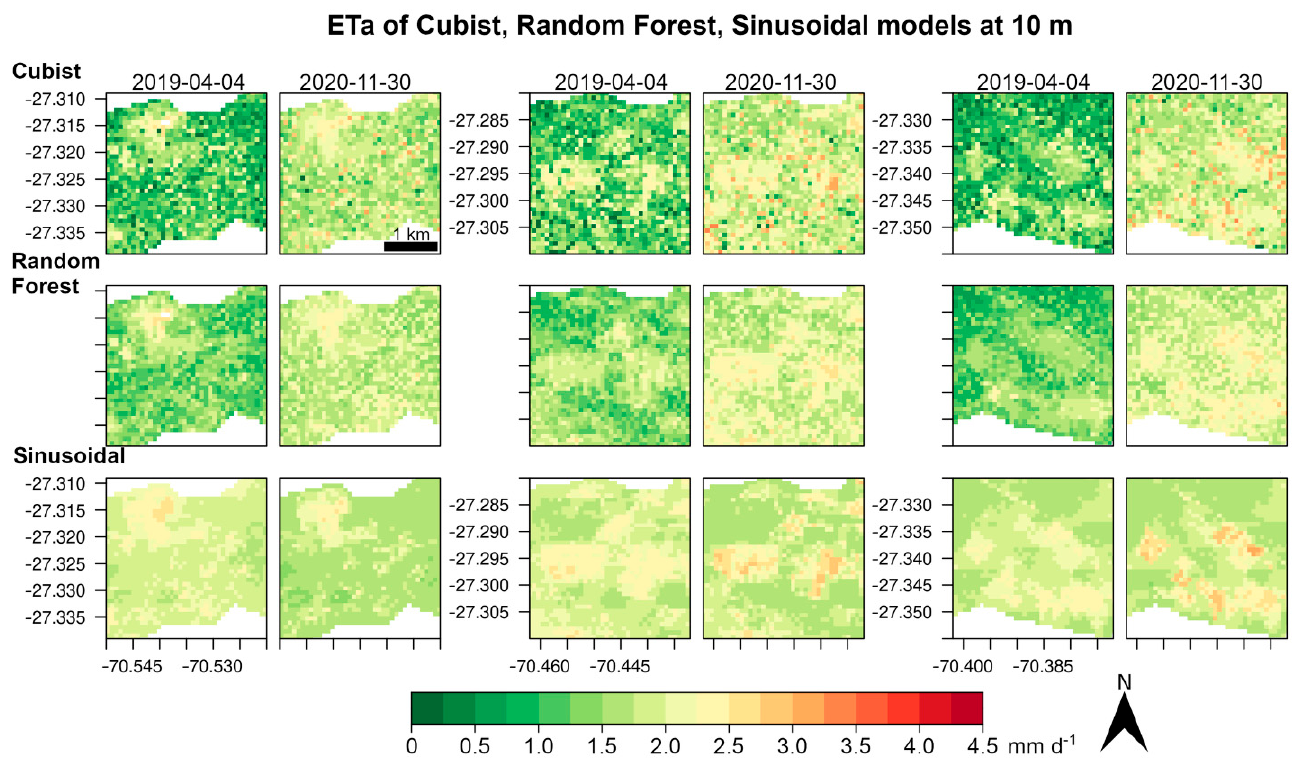
Figure 7. ETa based on Kmax at 10 m estimated from DLST with cubist, random forest, and sinusoidal models. When the ETa temporal series is analyzed at 100 m (Figure 8) and 10 m (Figure 9), the values estimated for olives match almost entirely with ETc from the stations and kc values defined in Table 1. The Cub model shows an underestimation in winter, but all the other models followed the ETc seasonal variation in situ with an underestimation in summer. For pomegranates, the trend is the opposite, where generally all the models overestimate the ETc of station from winter to summer; however, in late 2019 summer to 2020 autumn, the estimated ETa followed the same trend as the